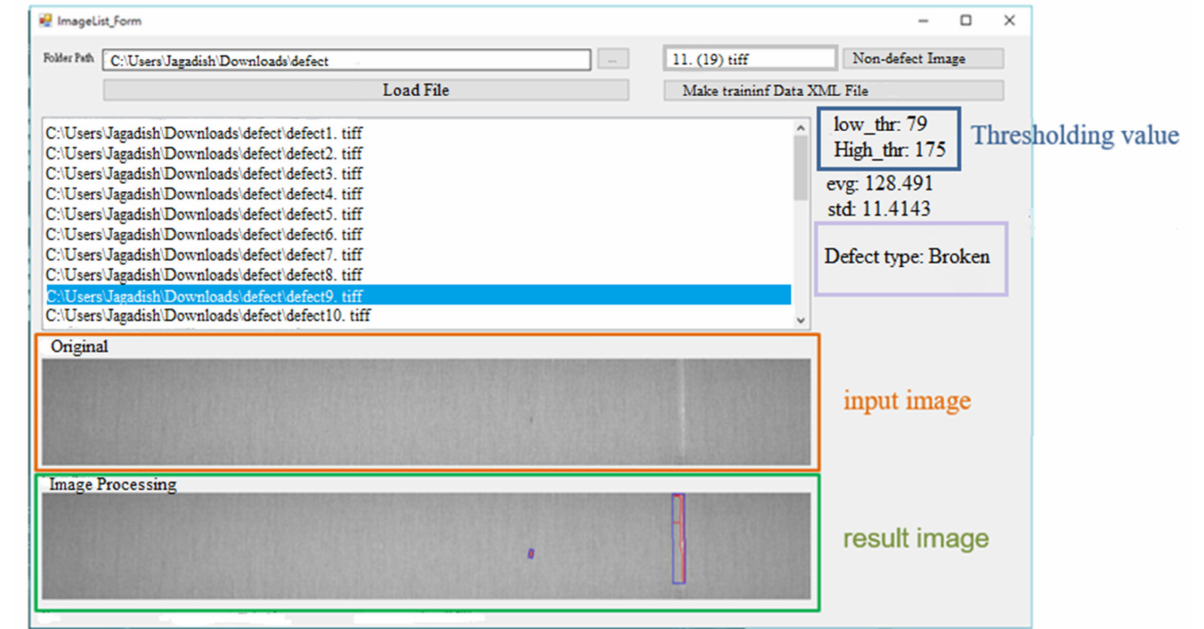
Figure 6. Graphical user interface for the developed system.